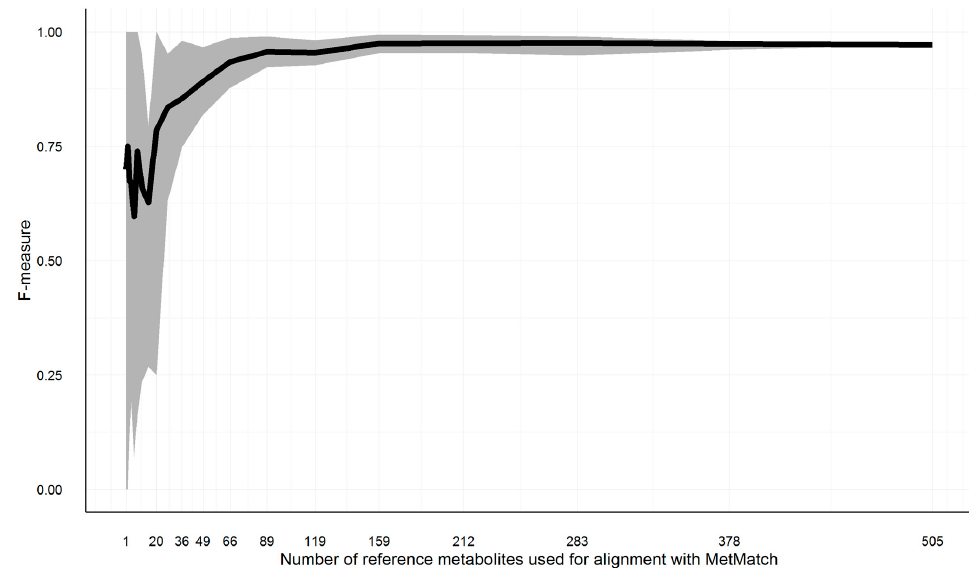
Figure 10. Illustration of the F-measure range (grey area) and average (black line) for reference feature lists of decreasing size. To estimate the minimum number of entries in the reference feature list, a simulation was carried out. In total, 200 subsets of decreasing size were generated. For each of the generated subsets, the m / z and Rt alignment step was calculated with MetMatch. The minimum (lower border of grey area), average (black line) and maximum (upper border of grey area) values are illustrated for each of the iterations.